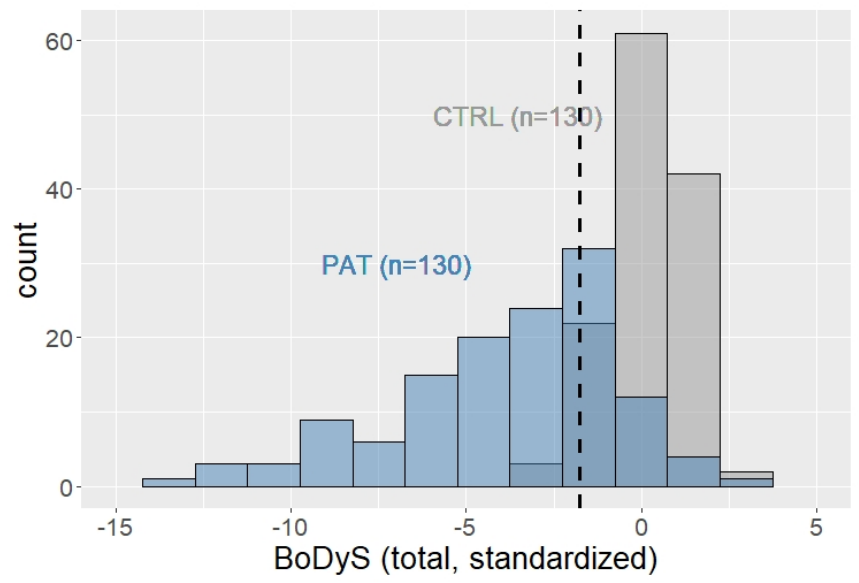
Figure A2. Distributions of standardized BoDyS total scores in the CTRL (grey) and the PAT groups (blue). The dashed vertical line indicates the 5%-cutoff of the CTRL scores.